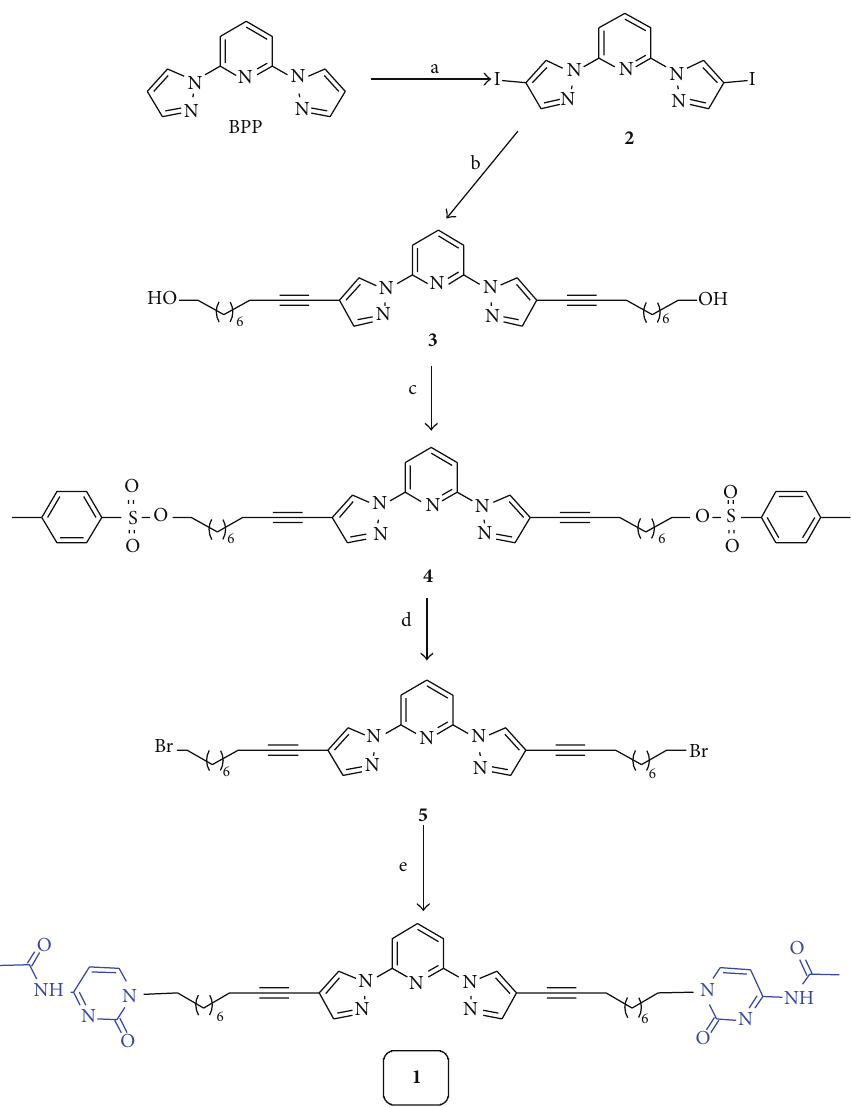
Scheme 1: Synthesis of cytosine decorated to 2,6-bispyrazolyl-pyridine derivative (1) . General reaction conditions: (a) as per